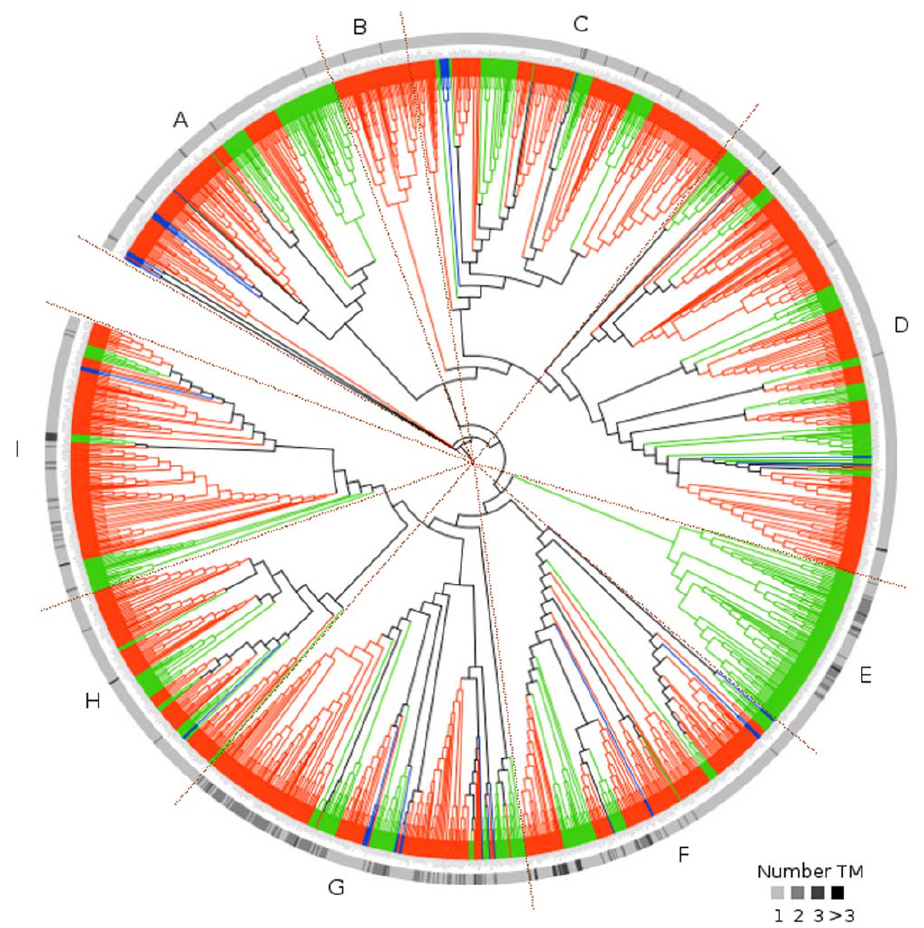
Figure 3. Phylogeny of 1815 ATL proteins from 24 plant species. The 42 amino acid sequence of the RING-H2 was used to generate the tree with FastTree; the tree is displayed in Figure S1. The branches were classified in 9 groups, A to I, collapsing branches with local support below 80%. Basal species are colored in blue, monocots in green and eudicots in orange. An outside circle represents presence of one or more transmembrane regions. ATLs have one or more transmembrane helix region toward the amino-terminal end, according to TMHMM, these are shown on a scale of shading. The basal gray color corresponds to one transmembrane helix.